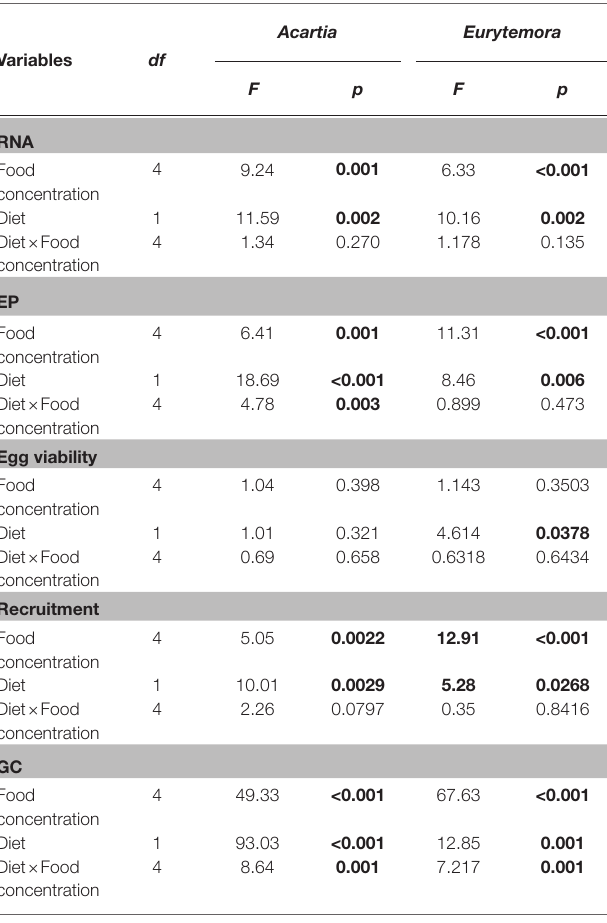
TABLE 2 | Two-way ANOVA; sigma-restricted parameterization, effective hypothesis decomposition: diet ( Nodularia/Rhodomonas vs. Rhodomonas ) and food concentration (0, 5, 25, 125, and 300 μ g C L − 1 ) effects on individual RNA content (RNA, ng ind − 1 ), egg production (EP, egg female − 1 ), viability (%EV),